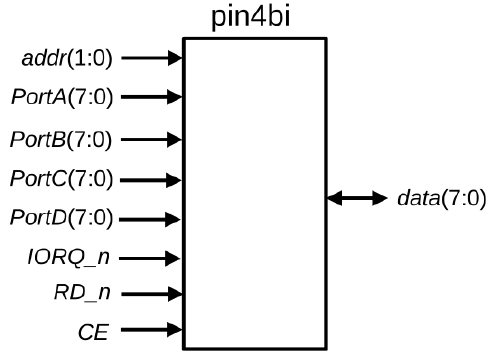
Figure 5. pin4bi pinout.